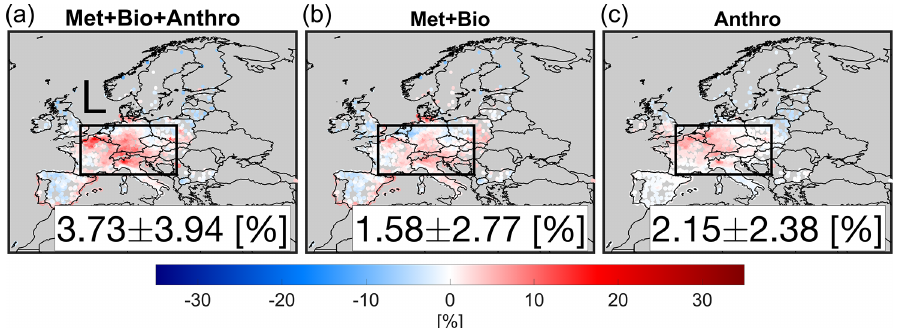
Figure 9. Simulated MDA8 surface ozone difference between April 2020 with respect to April 2019 including (a) dynamical meteorology, biogenic and anthropogenic emissions, (b) dynamical meteorology and biogenic emissions, and (c) the subtraction of the previous scenarios isolating dynamical anthropogenic emissions. Emissions used for these experiments are based on the top-down estimates.